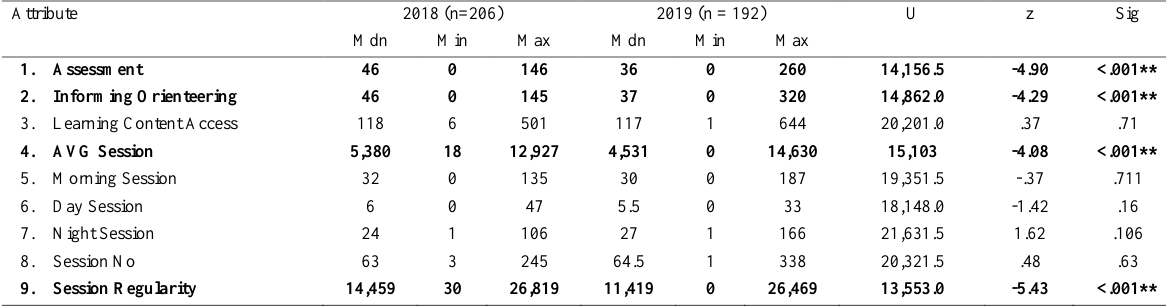
Comparison of Online Activity Between Cohorts in the Communication